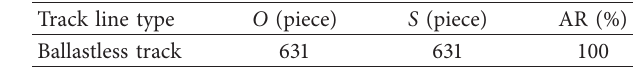
Table 1: The accuracy rate of rail